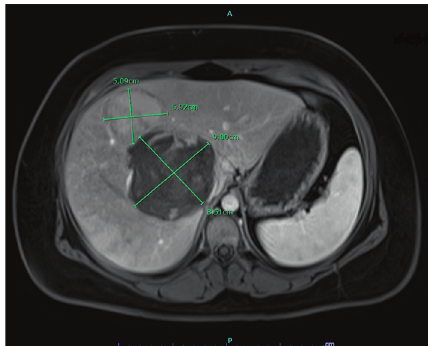
Figure 1: MRI of the liver with contrast showing a sizable hemorrhagic HA measuring 9.0 × 8.5cm and adjacent nonhemorrhagic HA 5.9 × 5.1 cm (segment 4) and several HAs smaller than 5 cm in diameter.